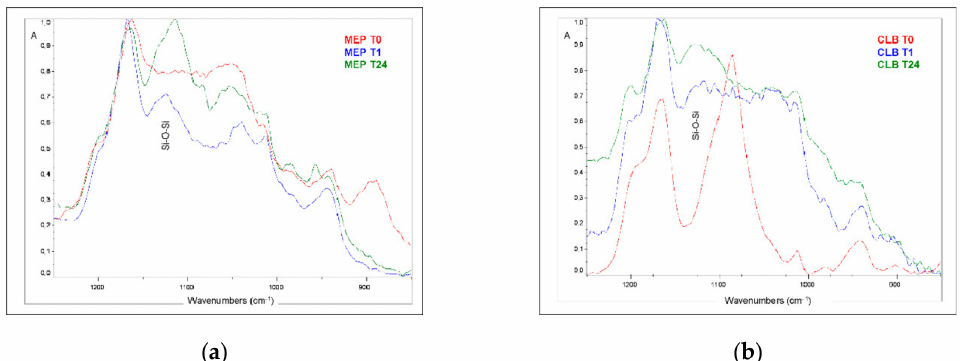
Figure 5. Micro-MIR FTIR spectra of MEP ( a ) and CLB ( b ) recorded immediately after application (T0), after 1 h (T1) and after 24 h (T24) storage (37 ◦ C / 70% RH). The developing Si–O–Si peaks due to the condensation reaction are clearly resolved (1250–850 cm − 1 wavenumber range).